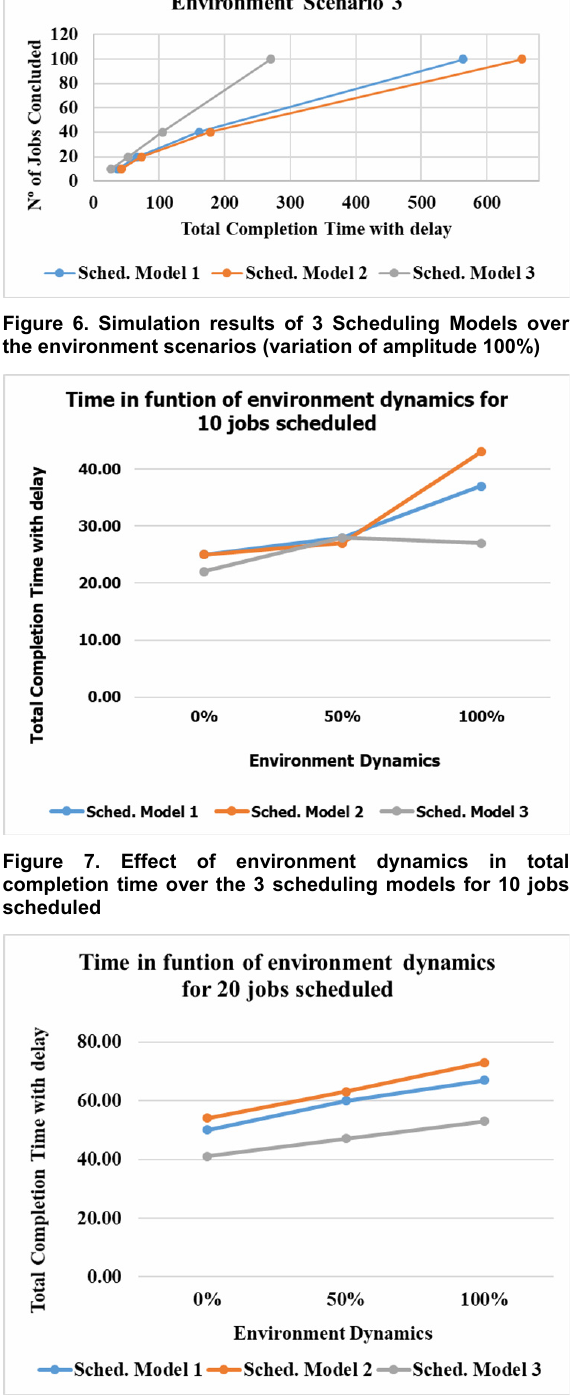
Figure 8. Effect of environment dynamics in total completion time over the 3 scheduling models for 20 jobs